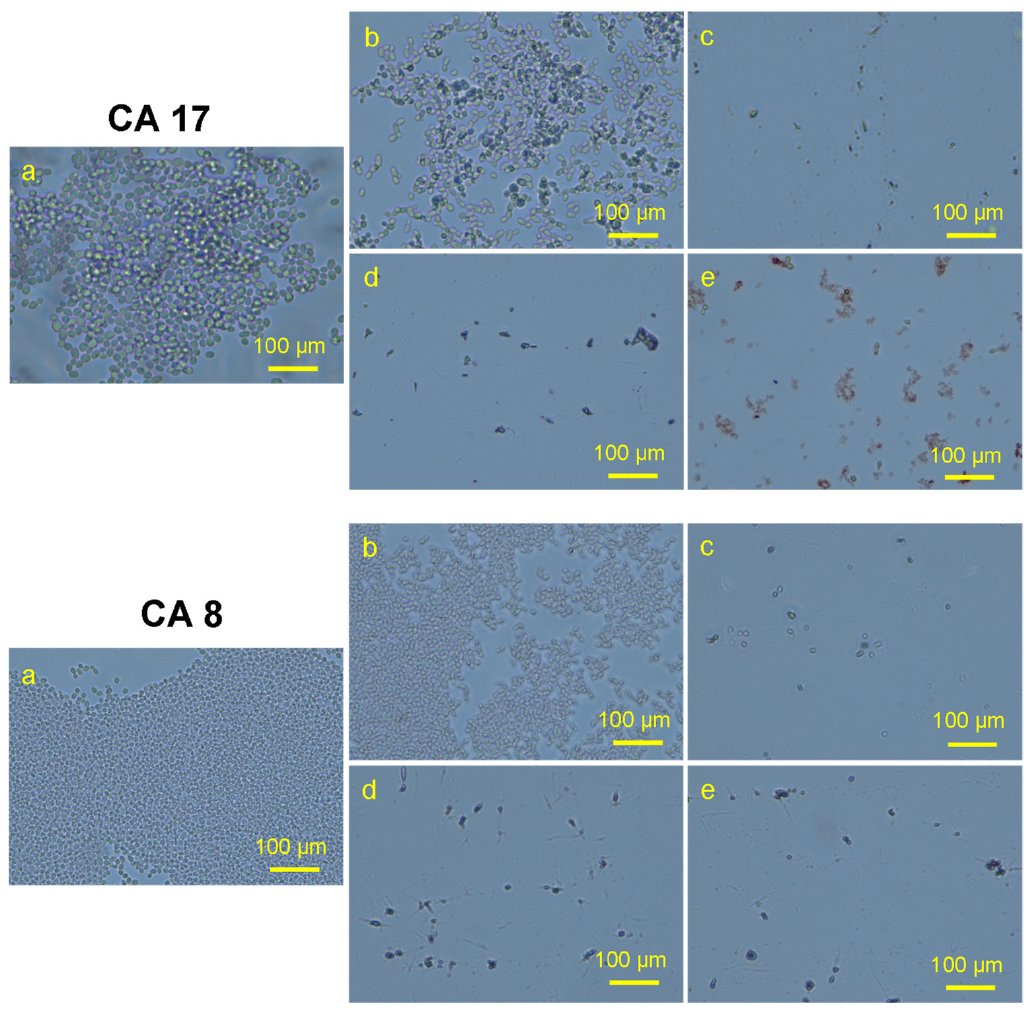
Figure 12. Representative microscopic slide pics of two C. auris strains showing the effect of synthesized nanomaterial on the planktonic cells using a light microscope. ( a ) Control (untreated); ( b ) Ti-ZSM-5; ( c ) Ag-silicate-1; ( d ), Ag/Ti zeolite; ( e ) AgNO 3 .